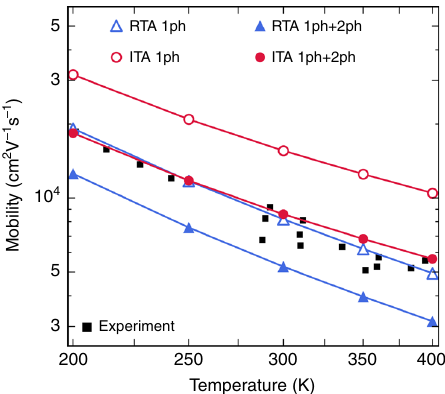
Fig. 7 Calculated electron mobility in GaAs. Electron mobility in GaAs, computed by solving the linearized BTE, both within the RTA and with an iterative approach (ITA). For each solution method, two sets of calculations are shown, one that includes only the 1ph leading-order processes and one that includes both 1ph and 2ph scattering. Experimental values are taken from refs. 33 − 39